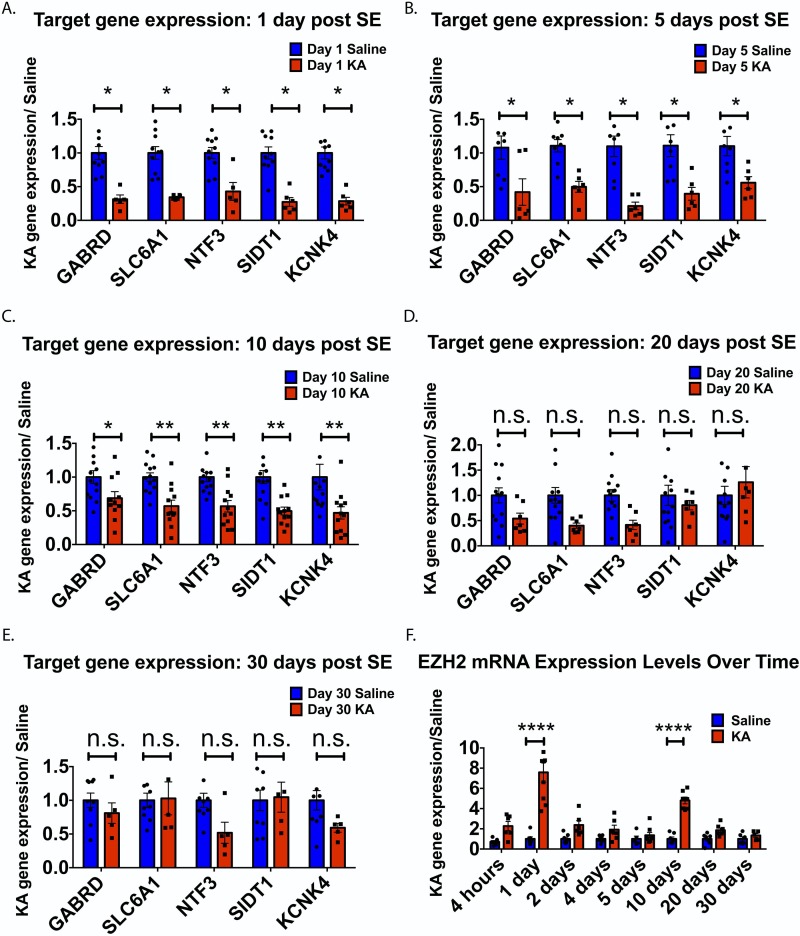
EZH2 mRNA levels exhibit early, transient increases after SE, while EZH2 target gene expression is down regulated out to 10 days.For panels (A-E), gene expression data for five tested EZH2 target genes are shown. All statistical tests were performed using multiple t-tests with Holm-Sidak correction for multiple comparisons;*p <0.05, **p < 0.01, ***p< 0.001, ****p <0.0001. n = 3–13 animals for saline and n = 5–13 animals for KA conditions. Target genes show significant down regulation after SE out to 10 days (A-C), with the exception of SLC6A1 and KCNK4 showing no difference compared to saline animals at day 5. Down regulation in SLC6A1 and KCNK4 returns at 10 days (C). By 20 and 30 days, differences in gene expression are abated (D-E). (F) EZH2 mRNA levels significantly increase at 1 day and 10 days post SE. Statistical significance was assessed by Two-way ANOVA and multiple comparisons were corrected for by Holm-Sidak correction. n = 6–7 animals for saline and n = 5–9 animals for KA conditions.